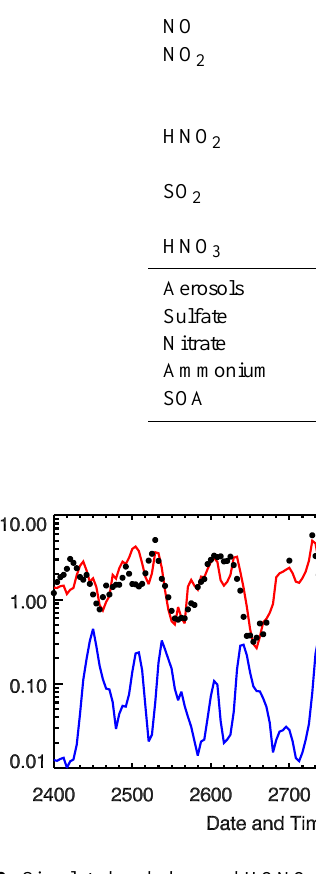
Fig. 3. Simulated and observed HONO at T0 during 24–29 March 2006. The black dots denote the observation, and the red and blue lines represent the simulations in the E-case and H-case, respec-